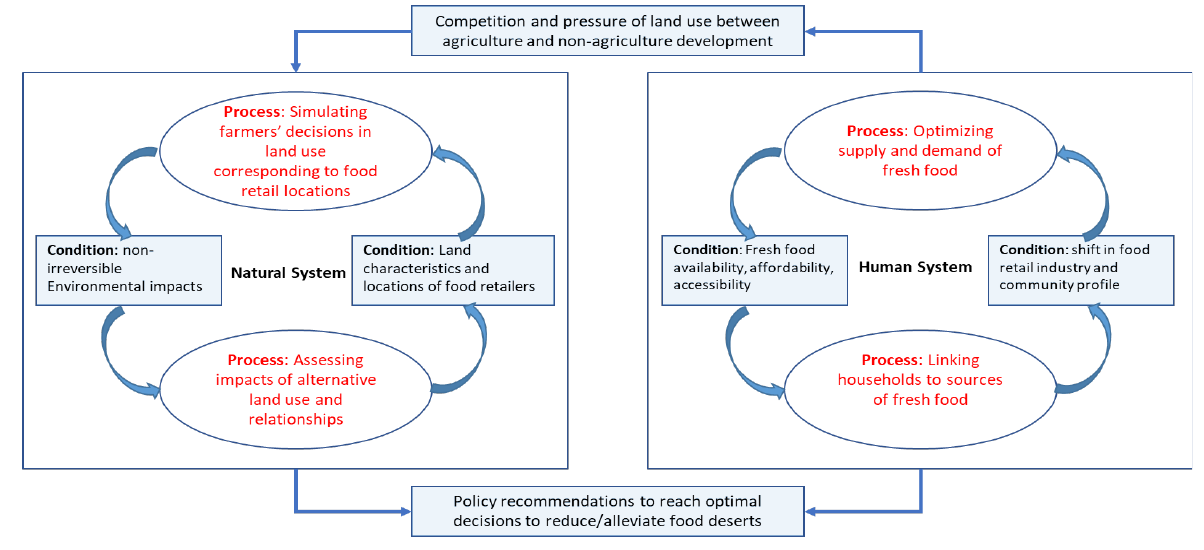
Figure 2. High-Level Schematic of the Dynamics of Coupled Human and Natural